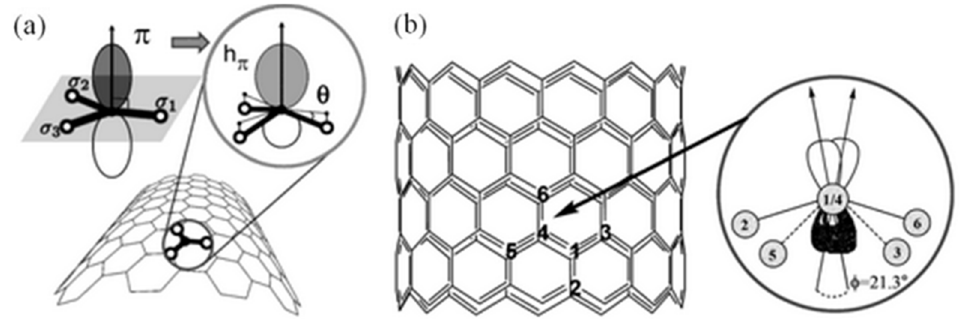
Figure 3. π -orbitals in planar graphene and changes under bending: ( a ) transformation into h π and pyramidalization, and ( b ) misalignment angles [6].